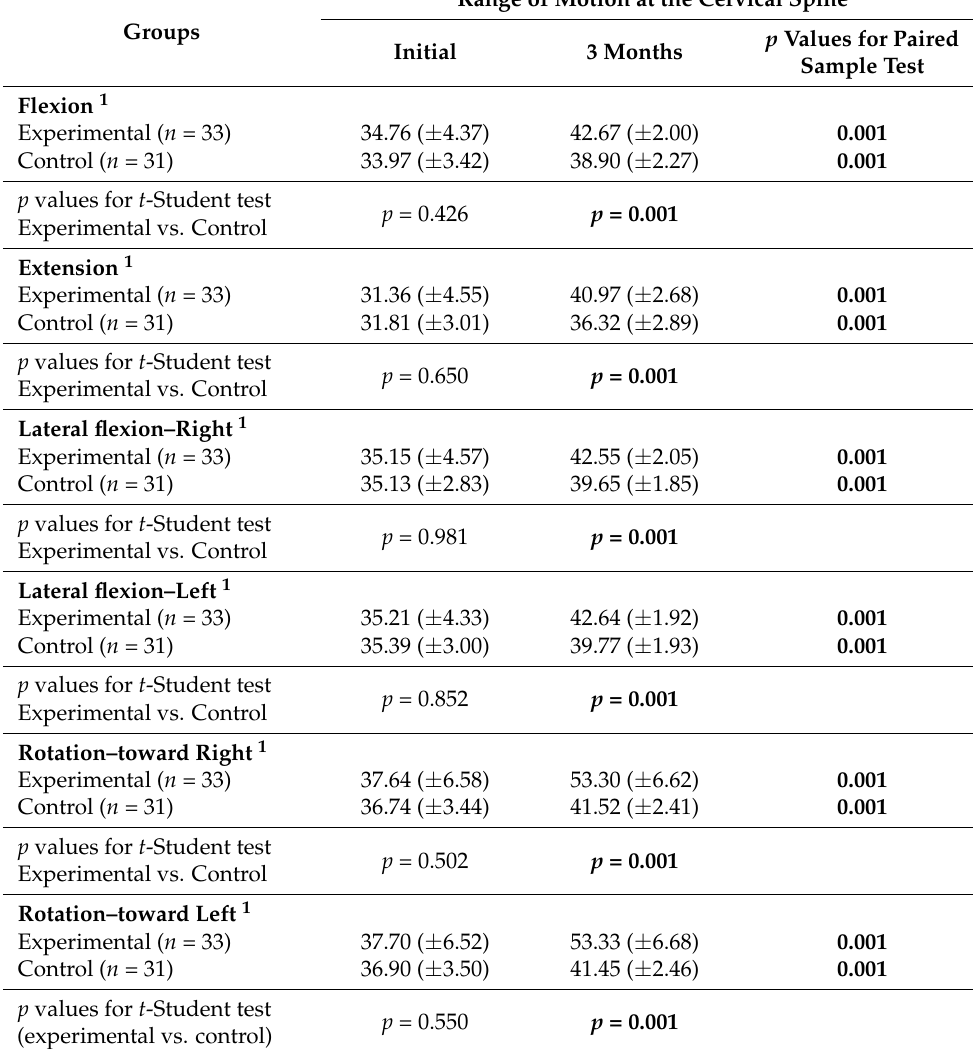
Table 5. Cervical spine joint